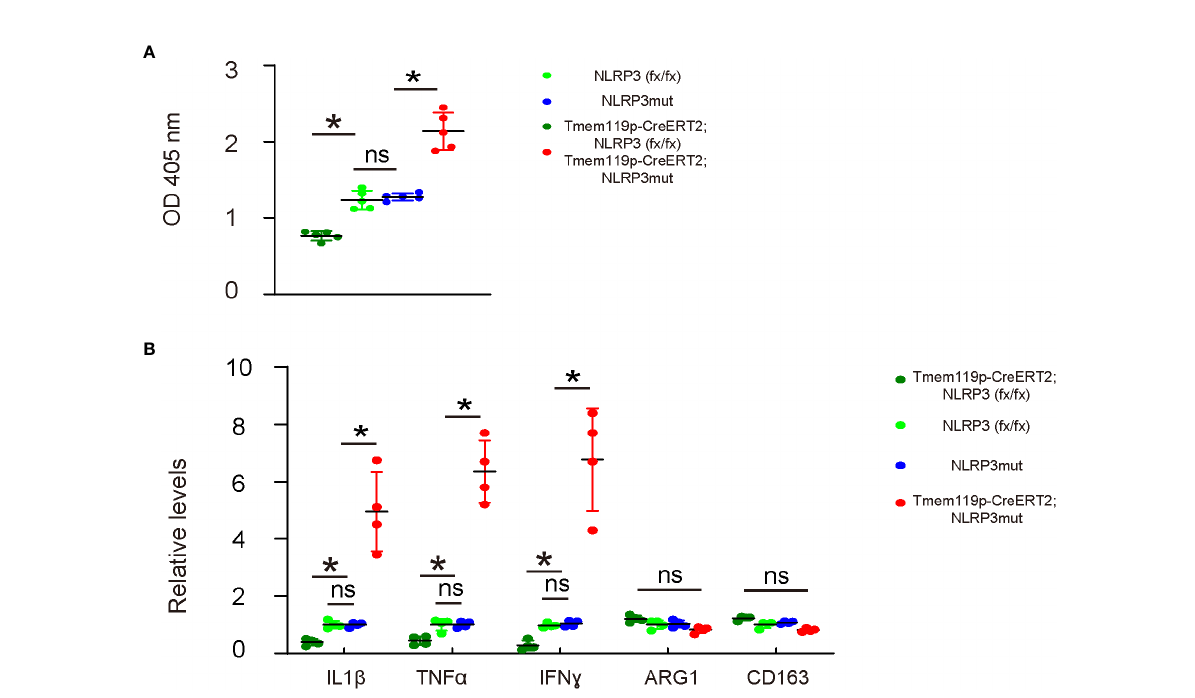
FIGURE 4 NLRP3 depletion in microglia reduces phagocytosis potential and release of pro-in fl ammatory cytokines. (A) Phagocytosis for zymosan was assessed in sorted disc microglia from mice with microglia-speci fi c alteration in NLRP3 expression. (B) ELISA for IL-1 b , TNF a , IFN ɣ , ARG1 and CD163 in sorted disc microglia from mice with microglia-speci fi c alteration in NLRP3 expression. The relative levels to those from NLRP3mut (=1) were shown. *p<0.05. ns, non-signi fi